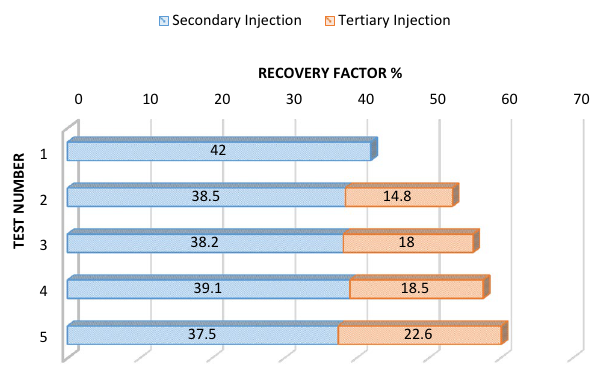
Fig. 10 Comparison of the oil recovery factors for sea water flooding and tertiary emulsion flooding